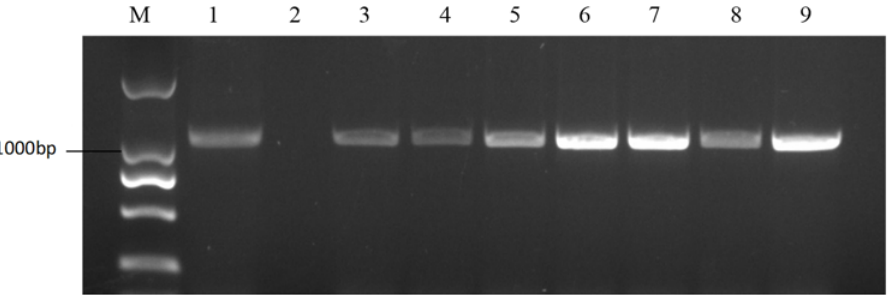
Figure 3. PCR amplification of KD4/KD7 in cabbages. M represents the DNA Marker 2000; 1 repre- sents the positive control; and 2 represents the negative control. Lanes 3–9 are cabbage materials with class II S-haplotypes.